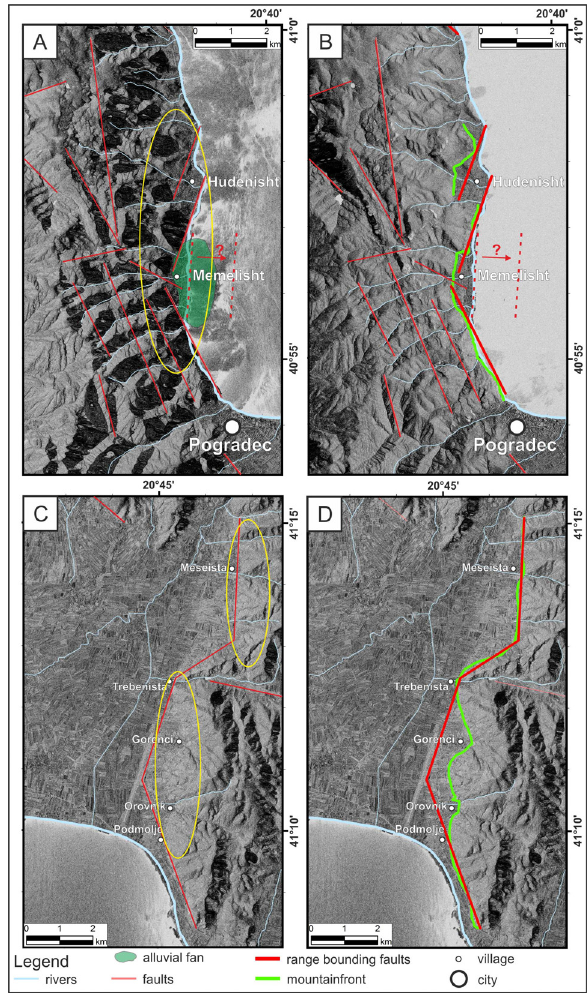
Figure 3. Mountainfront Sinuosity Index for two sites at Lake Ohrid, both exposing triangular facets in various states of degrada- tion. (A): Map view showing main faults in the Hudenisht area. Yel- low ellipse shows location of triangular facets and associated alluvial fans. (B): Mountainfront and range bounding faults in the Huden- isht area. (C): Map view showing main faults in the Meseista and Gorenci area. Yellow ellipse shows location of triangular facets and associated alluvial fans. (D): Mountainfront and range bounding faults in the Meseista and Gorenci